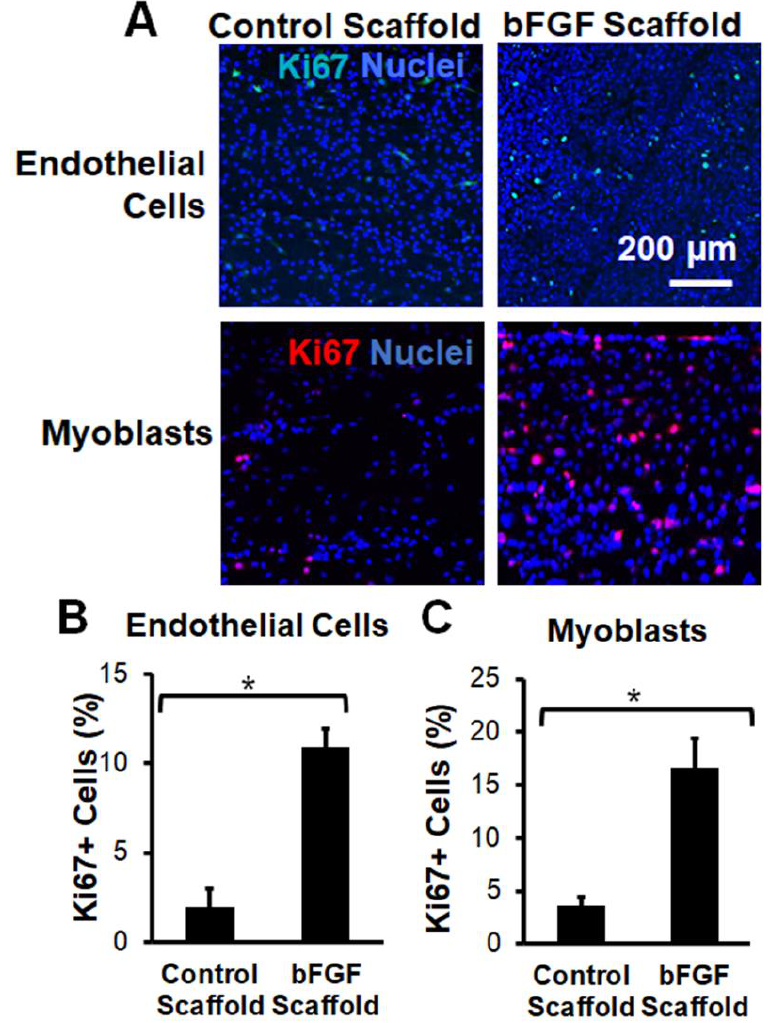
Figure 2. Bioactivity of bFGF-laden nanofibrillar scaffolds based on cellular mitogenic response. ( A ). Mouse myoblast (C2C12) and human endothelial (HMEC-1) cell lines cultured on the bFGF-laden scaffold or control scaffold for 4 days were immunofluorescently stained for Ki67. ( B , C ). Quantification of % Ki67 + endothelial cells ( B ) or myoblasts ( C ) show significant induction on the bFGF-laden scaffolds. Data are shown as mean ± SD ( n = 3). * indicates p < 0.05.